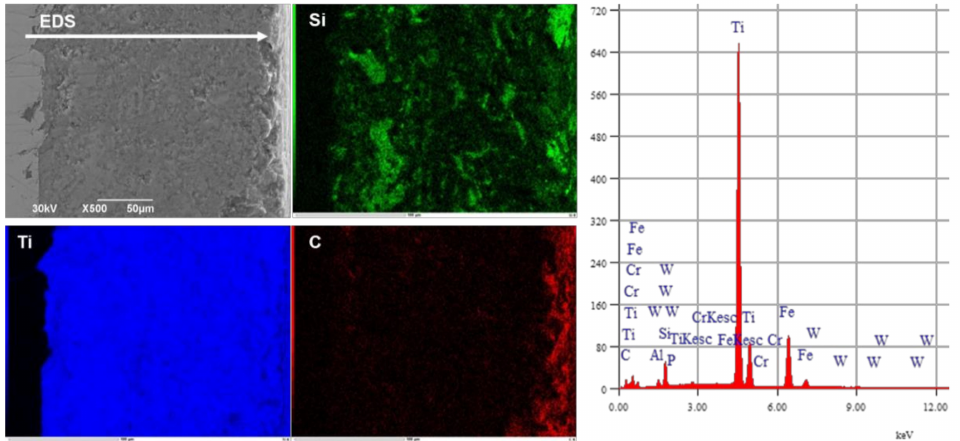
Figure 3. Cross-sectional microstructure of coatings with a color image of EDS mapping after PPT at a distance of 40 mm.